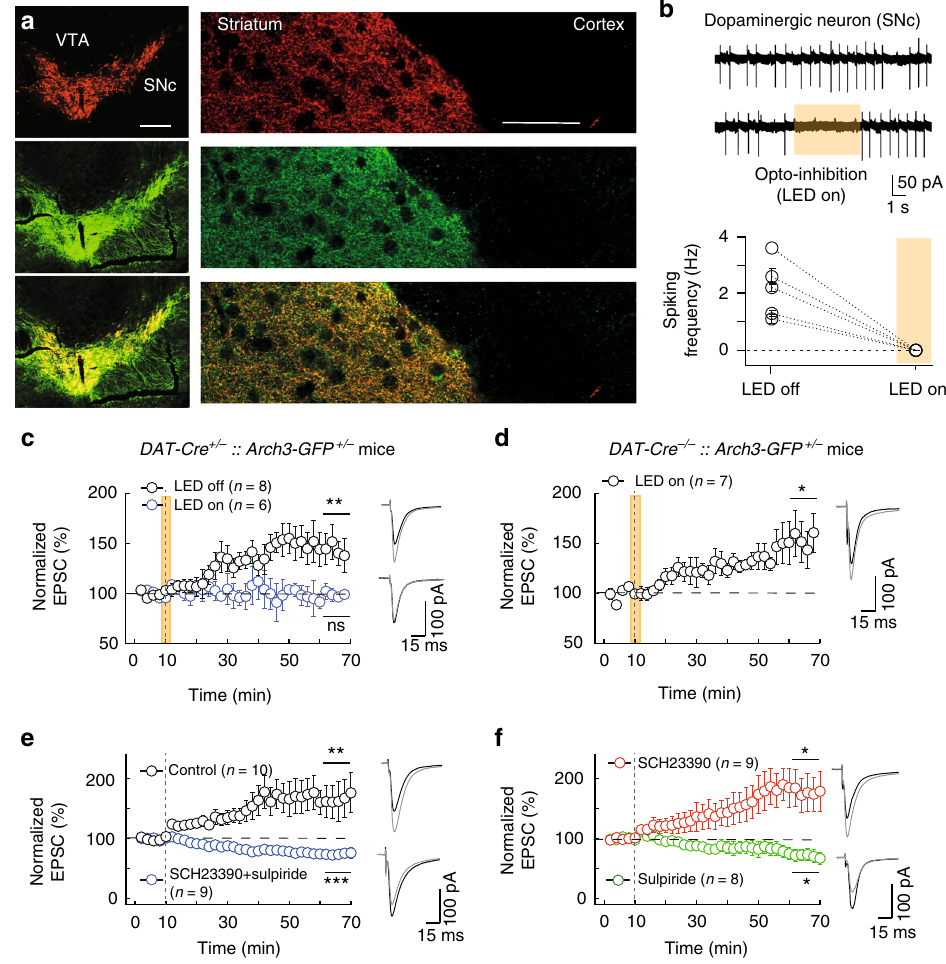
Fig. 3 eCB-LTP requires dopamine release during pairings and is D 2 R-dependent. a – d Induction of eCB-LTP requires dopamine release during the STDP paired-activity paradigm. a Double immunostaining for tyrosine hydroxylase (indicating dopaminergic cell bodies in SNc and dopaminergic afferences in striatum; upper panels) and GFP (indicating Arch3-expression; middle panels) in SNc (left panels) and in striatum (right panels); merge images are shown in the lower panels. Scale bars: 500 µ m (SNc) and 50 µ m (striatum). b Spontaneous fi ring of dopaminergic neurons recorded in cell-attached mode in DAT- Cre + / − ::Arch3-GFP + / − mice with and without light (upper traces). Summary graph showing all experiments performed in DAT-Cre + / − ::Arch3-GFP + / − mice with and without opto-inhibition. c 15 post-pre pairings induced tLTP ( n = 8, 6/8 cells showed tLTP) in DAT-Cre + / − ::Arch3-GFP + / − mice without opto- stimulation (LED off), while opto-stimulation (LED on) during STDP pairings prevents tLTP induction ( n = 6, 1/6 cells showed tLTP). This illustrates that eCB-tLTP requires DA release during STDP pairings. d 15 post-pre pairings induced tLTP with concomitant opto-stimulation (16 s duration) during STDP protocol in DAT-Cre − / − ::Arch3 + / + mice ( n = 7, 6/7 cells showed tLTP). In panels ( b – d ), the yellow areas illustrate when LED was on to promote an opto- inhibition. e , f 10 post-pre pairings ( − 30 < Δ t STDP < 0 ms) induced tLTP is D 2 R-activation dependent. Summary of STDP experiments showing that